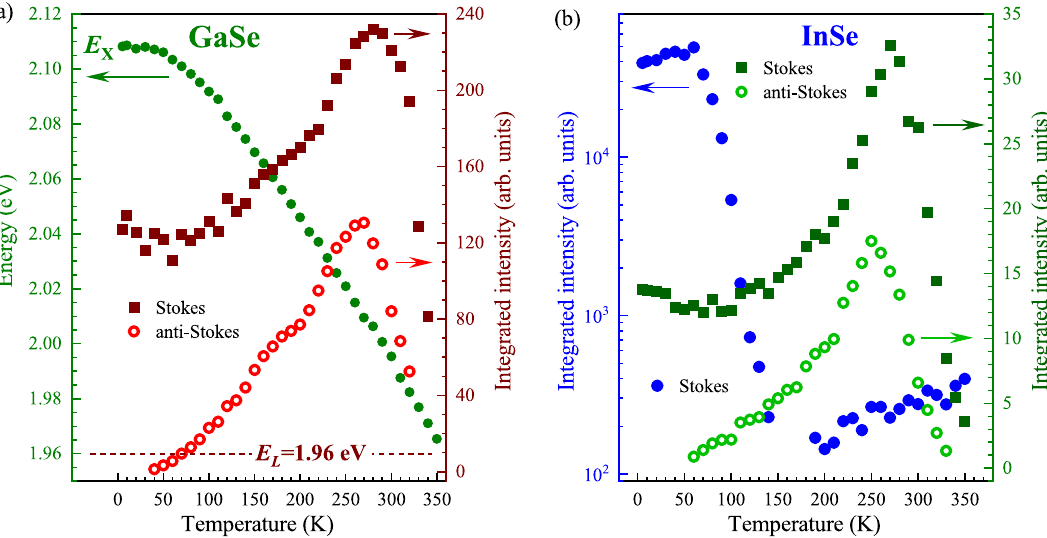
Figure 5. ( a ) The left hand scale refers to (green full points) the temperature evolution of the excitonic emission energy ( E X ) in GaSe. The right hand scale presents the corresponding (red full points) Stokes- and (red open ′ points) anti-Stokes-related intensities of the A 1 (1) modes under the 1.96 eV excitation marked by dark red dashed horizontal line. ( b ) The left and right hand scales refers the temperature evolutions of the (blue and green ′ full points) Stokes- and (green open points) anti-Stokes-related intensities of the A 1 (1) modes under the 2.41 eV (green points) and 2.54 eV (blue points)